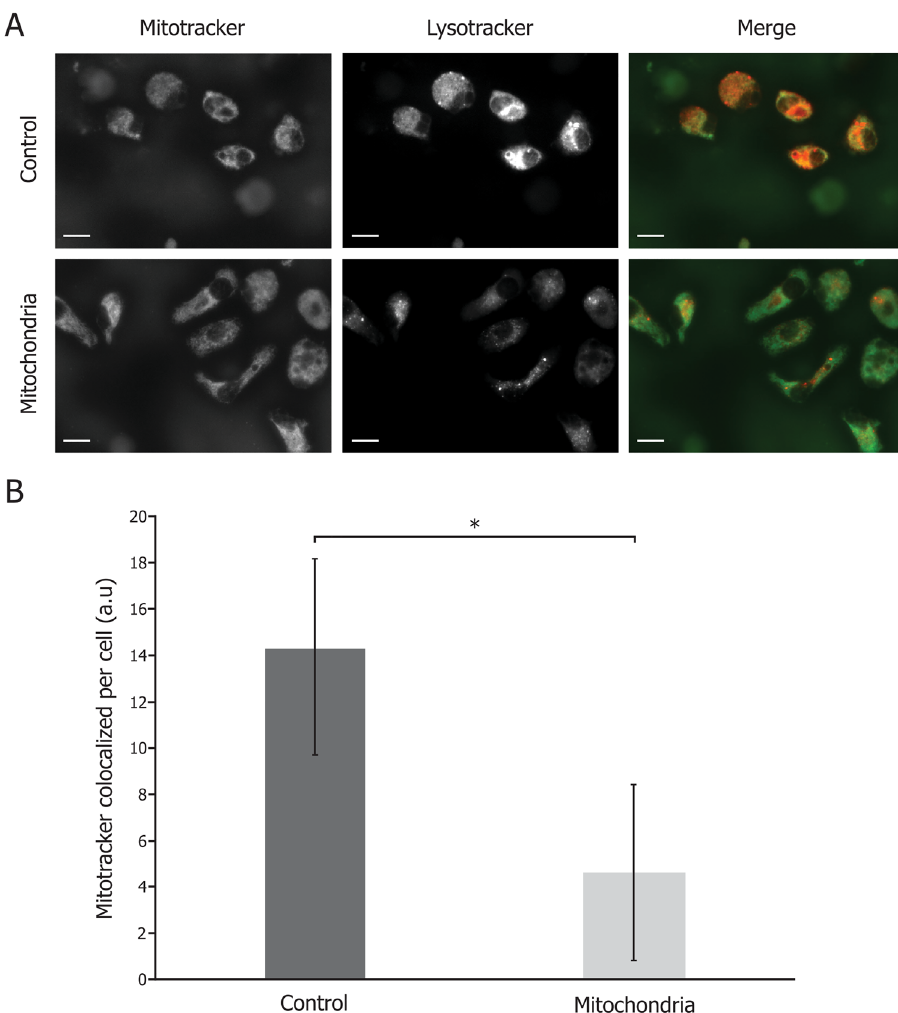
Figure 4. Reduction of mitophagy by mitochondria internalization by co-incubation with FECD cells. ( A ) A marker of lysosome (lysotracker; red) was used in conjunction with a mitochondrial mass marker (mitotracker; green) in FECD explants exposed to exogenous mitochondria or not (Control). ( B ) Colocalization of the mitotracker and lysotracker signals is lower in the FECD explants that received exogenous mitochondria compared to controls. Scale bar = 40 µm. Experiments were performed with 4 explants from 4 FECD patients (43 microscope fields analyzed). *p <